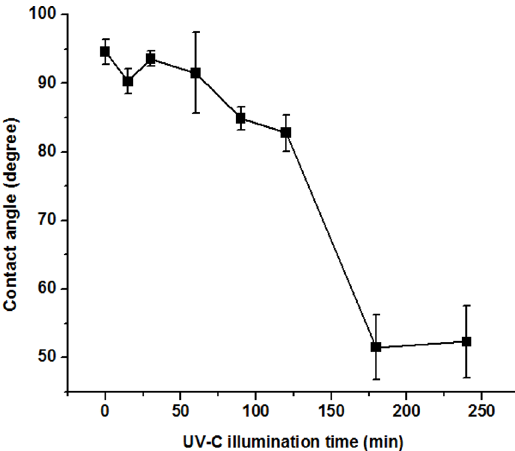
Figure 6. Contact angle measurements as a function of UV radiation exposure, for sample S3 (Ar/O = 0.886). 2 molecules on the surface of material is the responsible